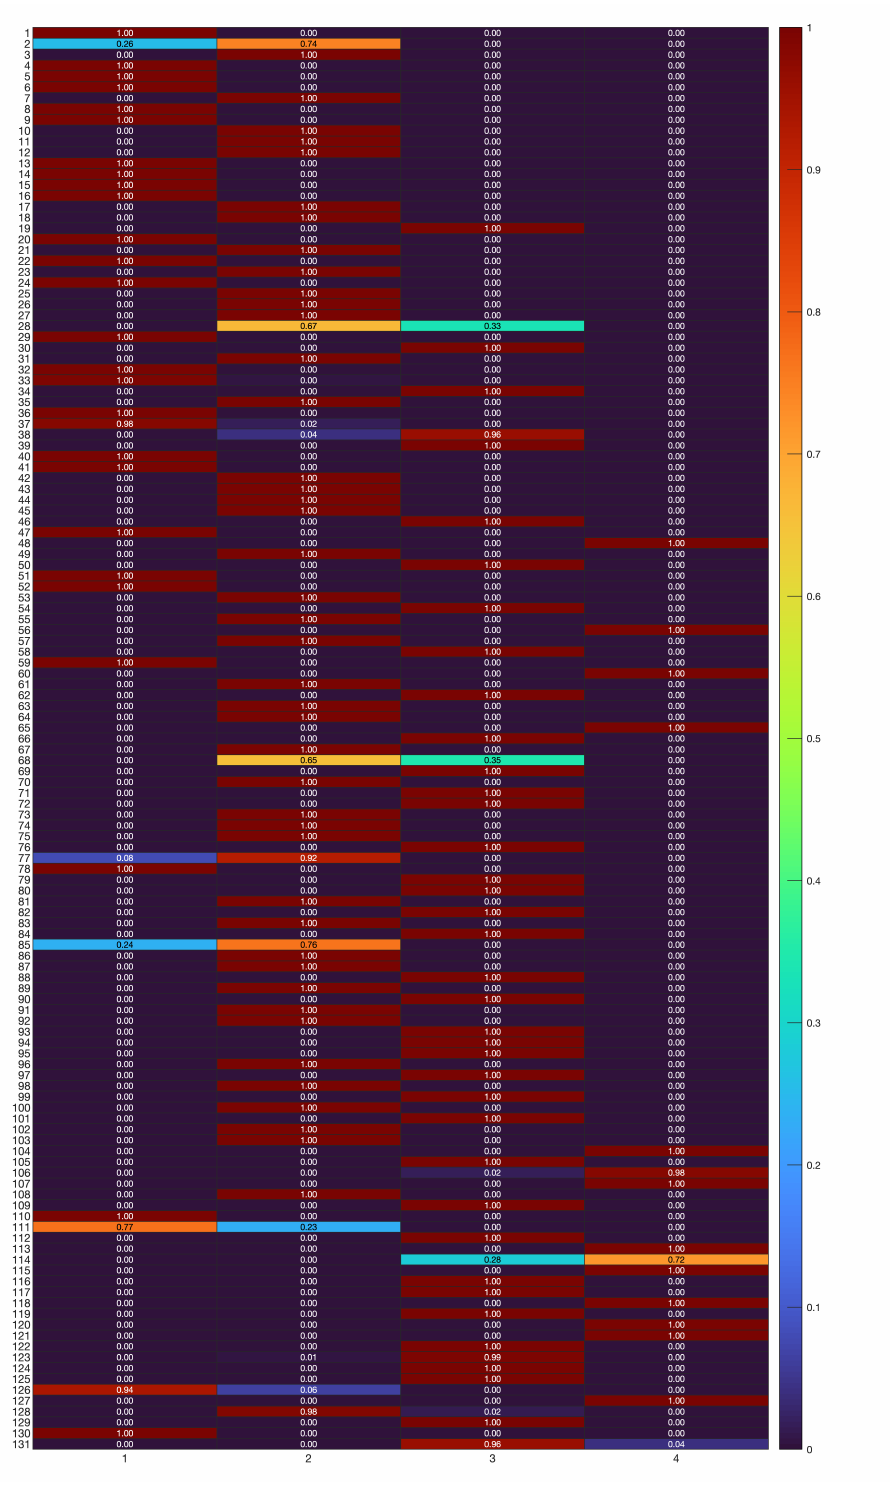
Figure 3. Classification results with B-spline regression mixtures. “Soft” partition of the 131 time series (rows) into K = 4 clusters (columns), represented by (cid:98) π ik in